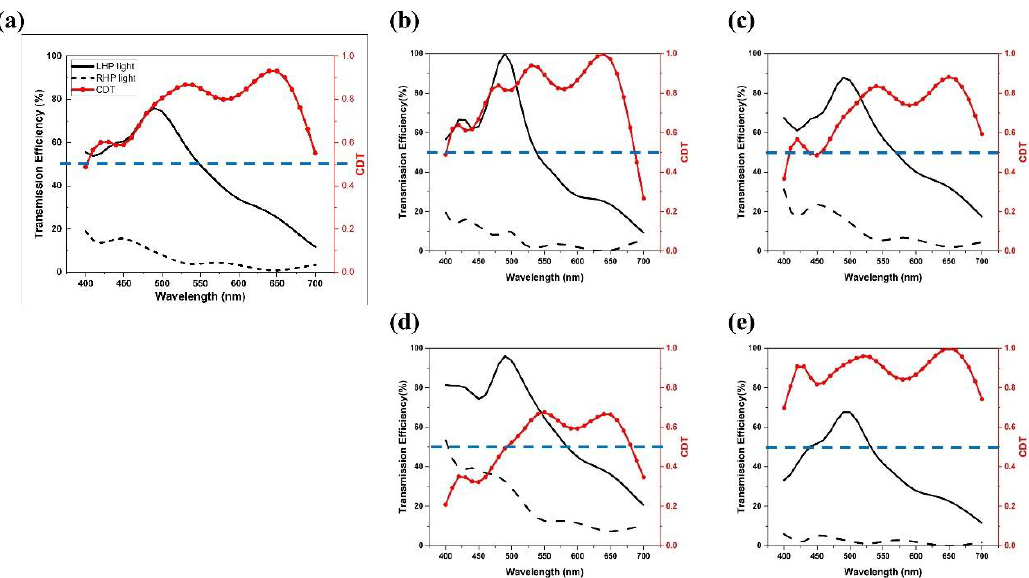
Figure 6. Black lines are the transmission spectra of our LHDCP under LHP and RHP incident light. The red line is the CDT calculated from the above two transmission spectra. Results for: ( a ) Period 170 nm, Width 30 nm, ( b ) Period 160 nm, Width 30 nm, ( c ) Period 180 nm, Width 30 nm, ( d ) Period 170 nm, Width 20 nm, ( e ) Period 170 nm, Width 40